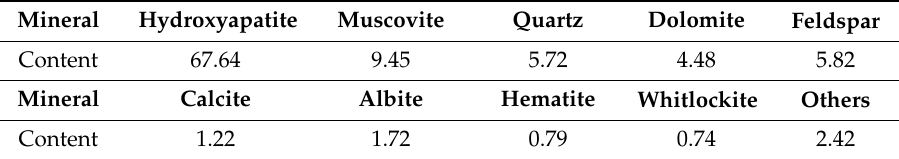
Table 2. The modal mineralogy of the phosphate ore by mineral liberation analysis (wt %).